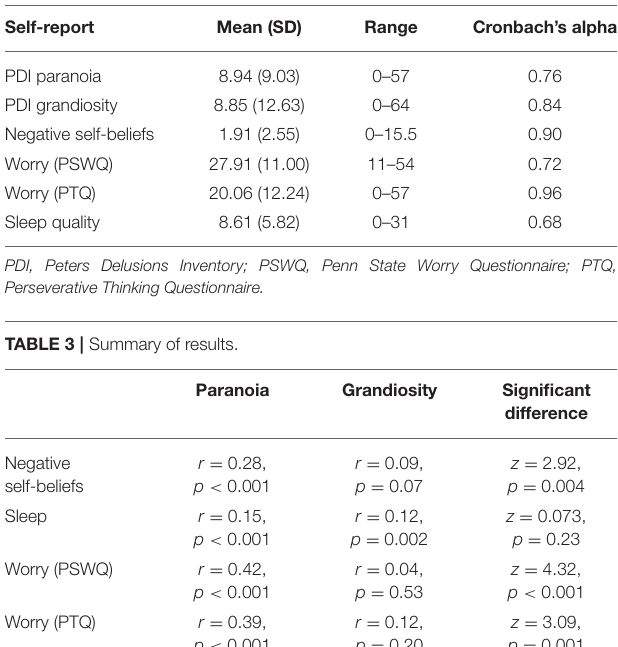
TABLE 2 | Descriptive statistics for self-report measures.